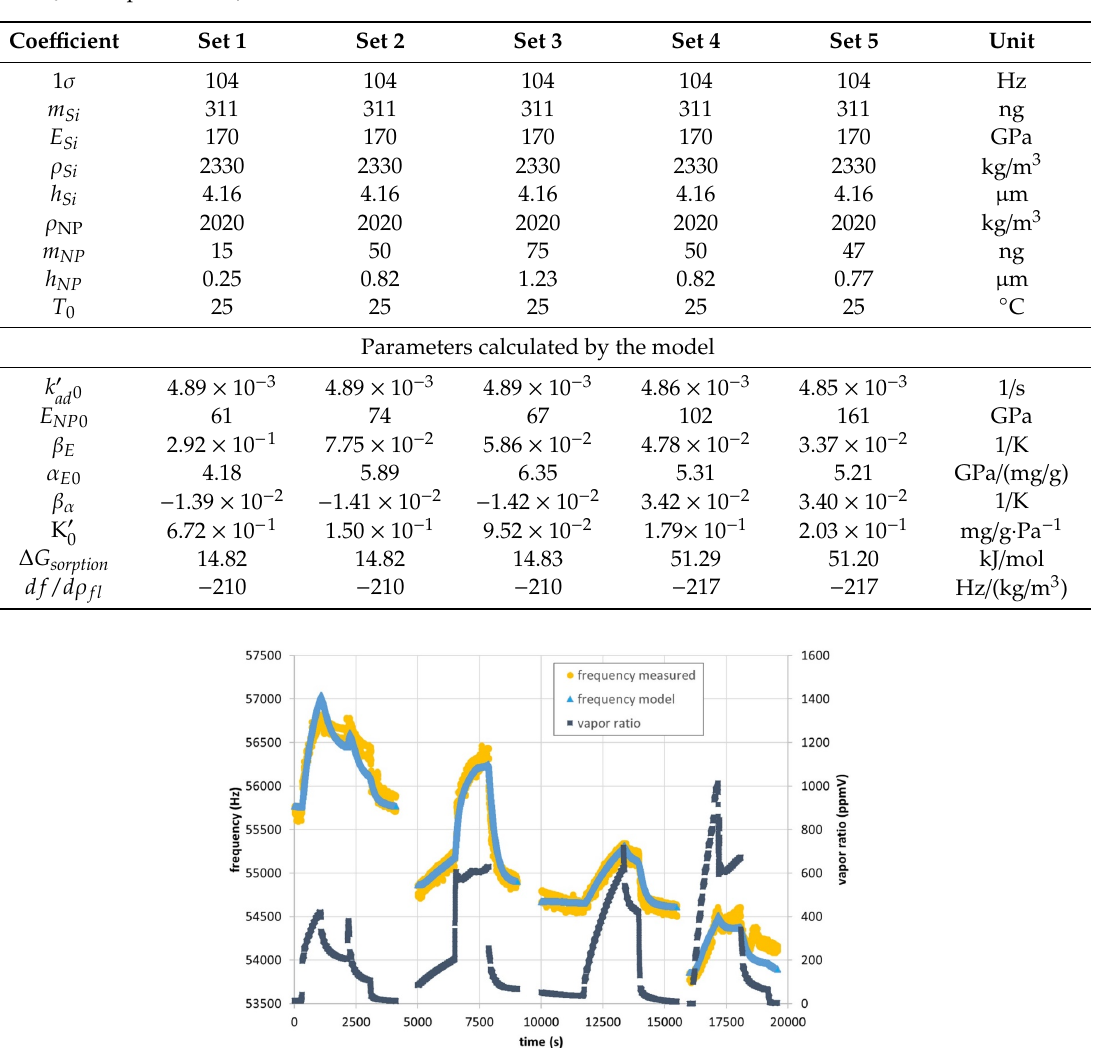
Table 4. Di ff erent sets of coe ffi cients for the model fit of CBV100-coated #162 chip (coe ffi cients m Si to T 0 are kept constant).